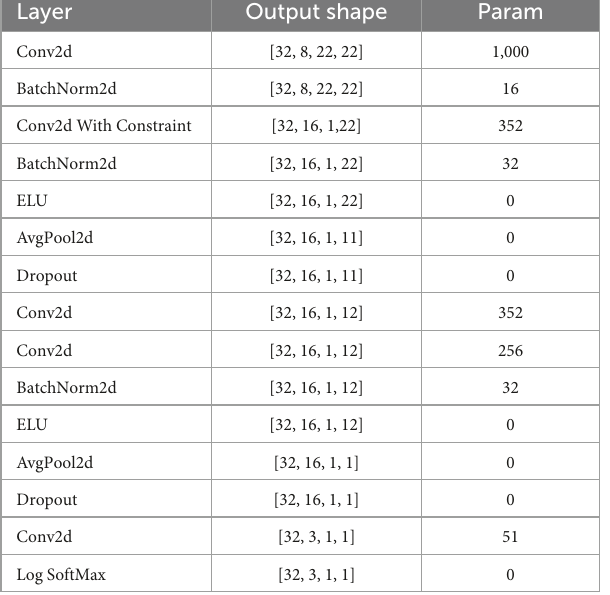
TABLE 2 The improved CNN network structure that classifies the PLI matrix, including the layer, the output shape of data, and the number of parameters.